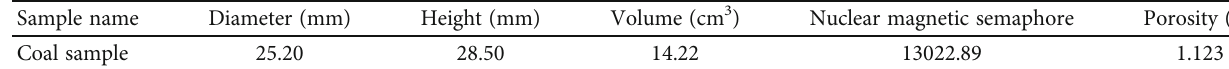
Figure 1: MacroMR12-150H-I nuclear magnetic resonance equipment. Table 1: Parameters of coal samples.